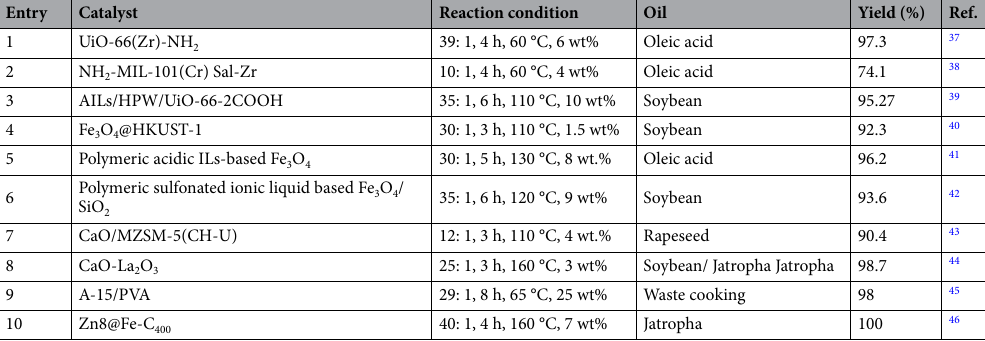
Table 1. Comparison between bifunctional catalysts based on MOF and other proposal materials for biodiesel production.